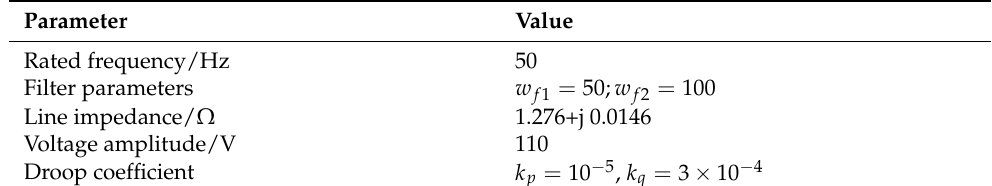
Table 2. Relevant parameters set by the system.